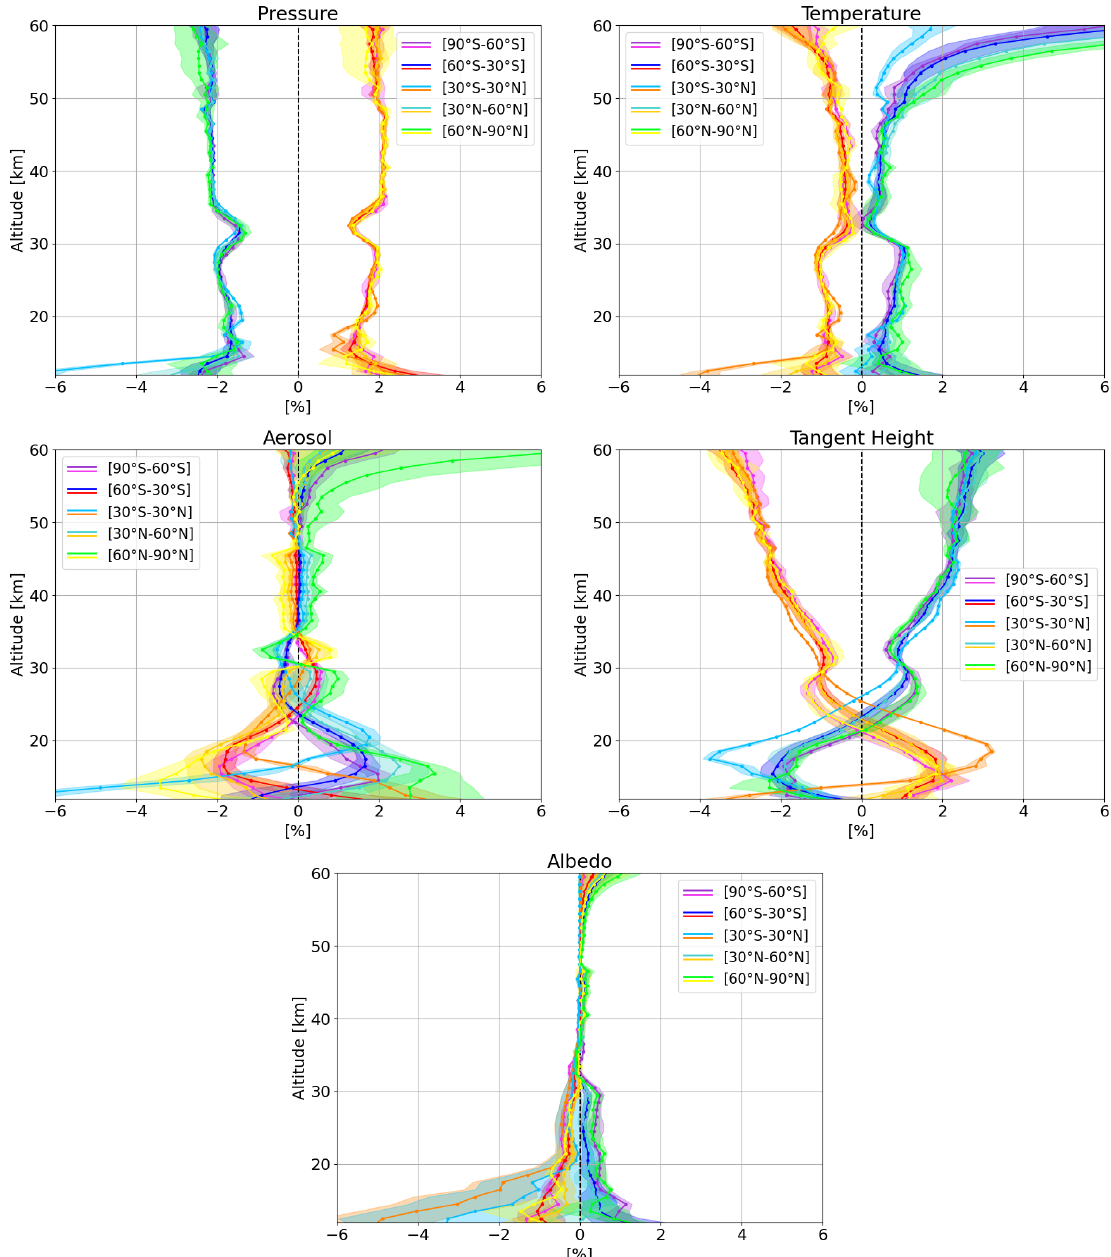
Figure 6. Estimation of parameter errors from synthetic retrievals in terms of the relative uncertainty on the ozone profile. Each panel refers to the parameter specified in the title, which is perturbed according to Table 2. Warm colors indicate a positive perturbation of the parameter, cold colors a negative one. Latitude bands are indicated in the legend, and the shaded areas around each profile indicate the scattering of the uncertainty as a function of